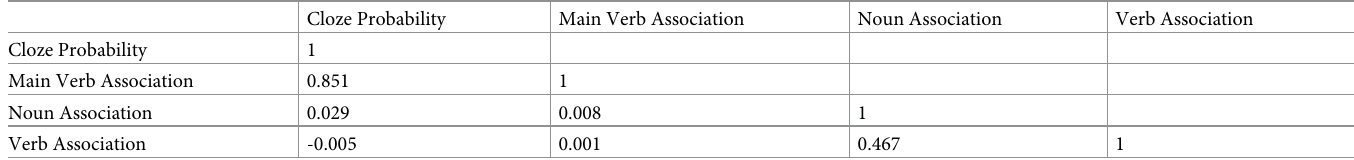
Table 3. Correlations. Correlations between stimulus